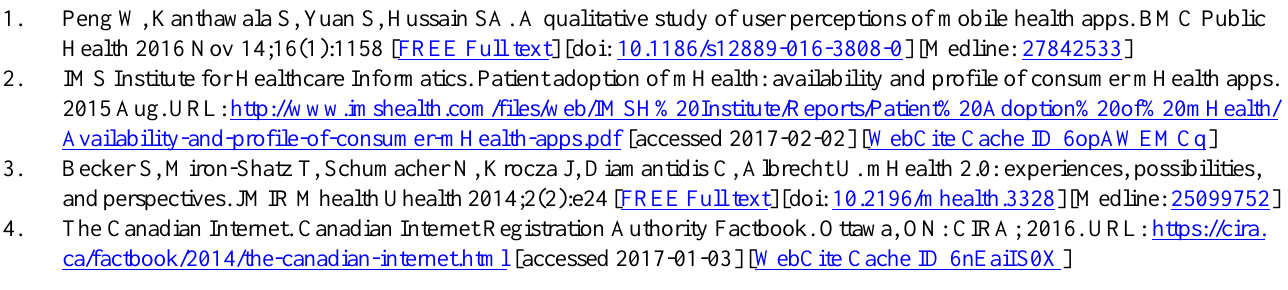
(Table 3). For postexercise HR detection, facial PPG underestimated HR values with mean differences of approximately 1 beat/min or median differences of 1-2 beats/min when compared with ECG HR (Table 3). Possible explanations are blushing and excessive facial motion due to heavy breathing after exercise leading to misalignment of the face with the